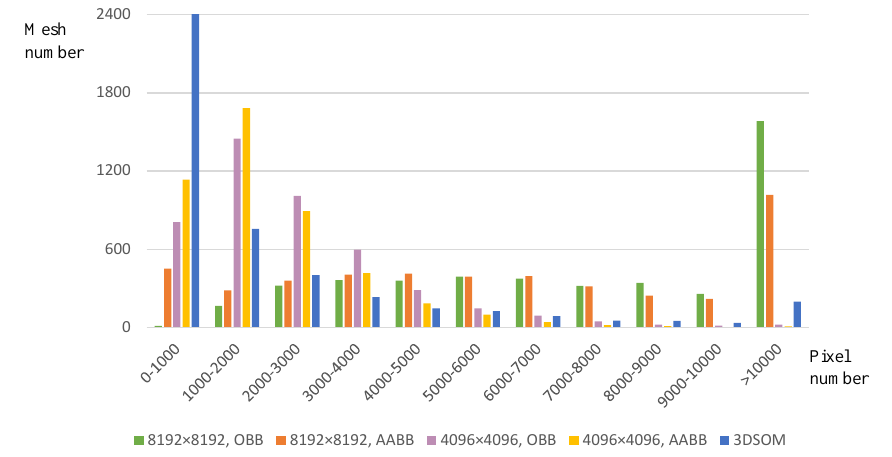
Figure 12. The bar chart of mesh number vs. pixel number for five cases: 8192 × 8192/OBB, 8192 × 8192/AABB, 4096 × 4096/OBB, 4096 × 4096/AABB and 3DSOM software.